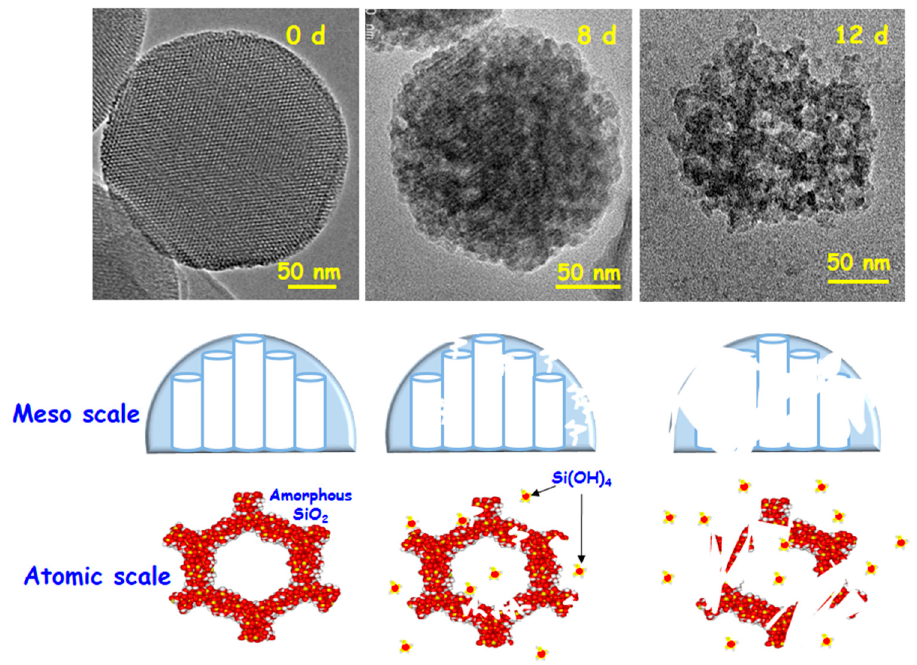
Figure 6. Representative illustration showing the in vitro degradation process in PBS for MSNs. TEM images before and after 8 and 12 days of in vitro assay are shown. The cartoons display the degradation process at the meso and atomic scales.